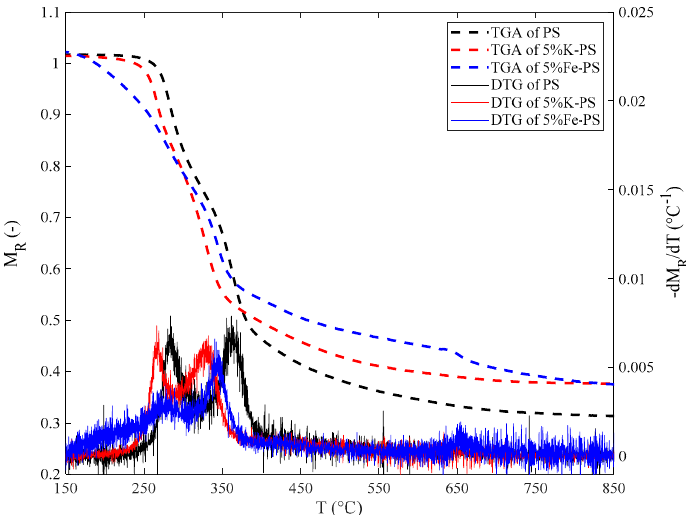
Figure 1. TGA and DTG diagrams from pyrolysis of PS, 5%K-PS, and 5%Fe-PS of residual mass fraction (M R ) and -dM R /dT vs. temperature at heating rate = 30 °C min − 1 in N 2 .